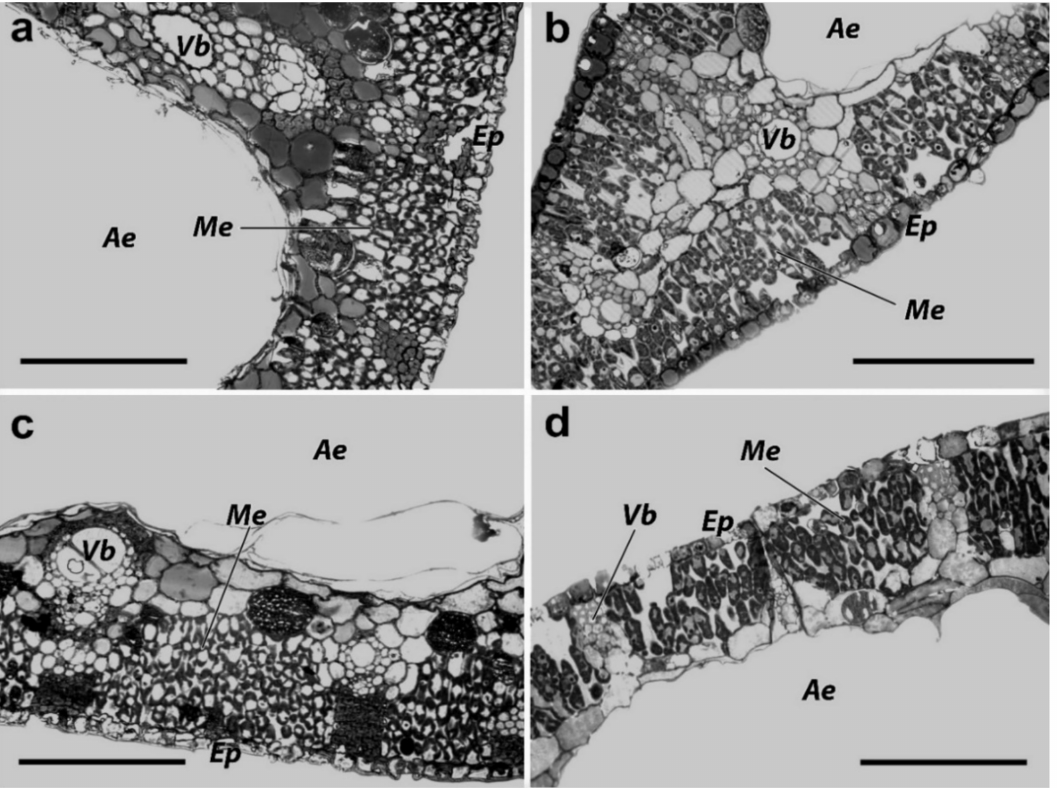
Figure 7. Cross-section of the leaves; T. australis: ( a ) background plot (5K), ( b ) polluted plot (8K); T. laxmannii : ( c ) background plot (T1), ( d ) polluted plot (T4). Me;—mesophyll; Ae—aerenchyma; Vb—vascular bundle. The scale bar is 100 µ m.